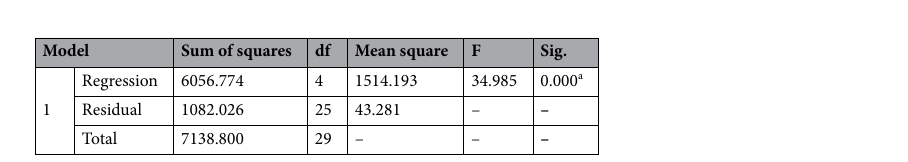
Table 8. Anova. Dependent variable: y a Predictors: (Constant), f 4 , f 3 , f 2 , f 1